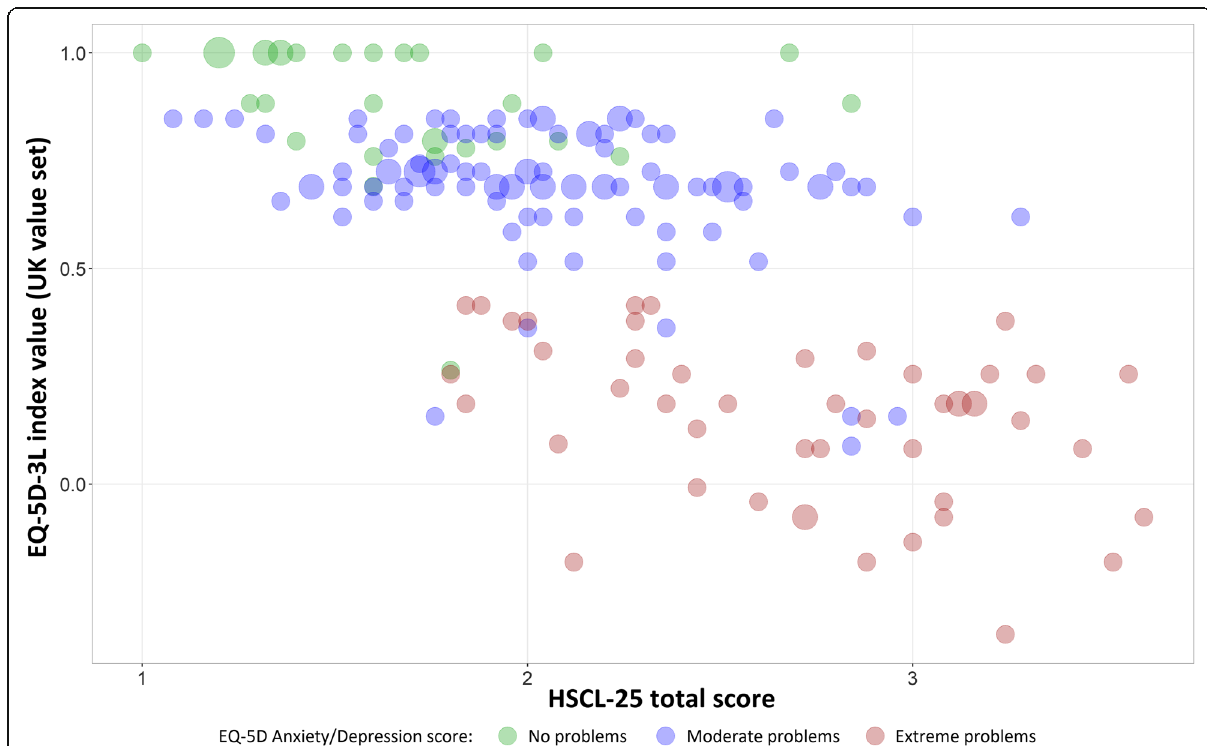
Fig. 2 Observed self-reported EQ-5D-3L index scores (UK value set) over corresponding HSCL-25 total scores in the SUD population. Circle area proportional to number of participants assigning particular combination. Circle colors represent self-rating on the Anxiety/Depression dimension of the EQ-5D-3L: green, no problems; blue, moderate problems; red, extreme